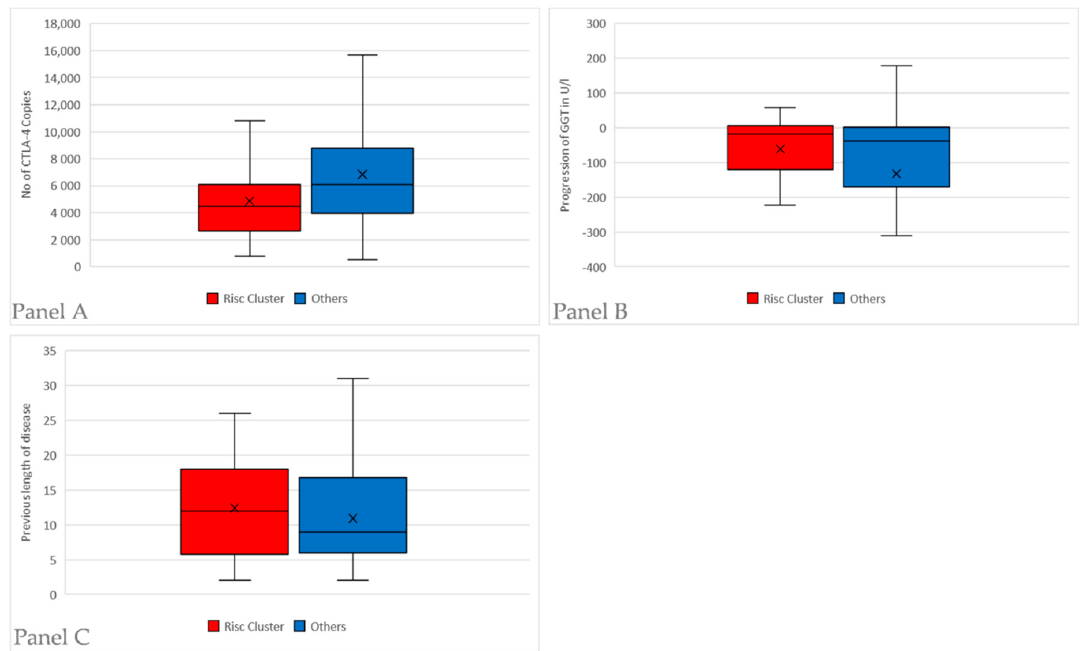
Figure 2. All patients were subgrouped by their allele variants in the two SNPs CTLA4 rs733618 and FOXP3 SNP rs2280883. If they were both homozygotic with the major variant (TT), defined as the predominant allele in the HapMap-population, they were included in the “risk cluster” ( n = 44). Afterwards, they were compared with the remaining patients with a different allele variant in the two SNPs ( n = 81). Panel A: Comparison of the number of CTLA-4 copies measured by mRNA Real-Time PCR and normalized using β -Actin as internal control. Patients in the “risk cluster” have lower number of CTLA-4 copies (5729 vs. 9429, p = 0.001). Panel B: Comparison of GGT progression by subtracting the lab values at initial diagnosis with the most current values for each patient. Patients